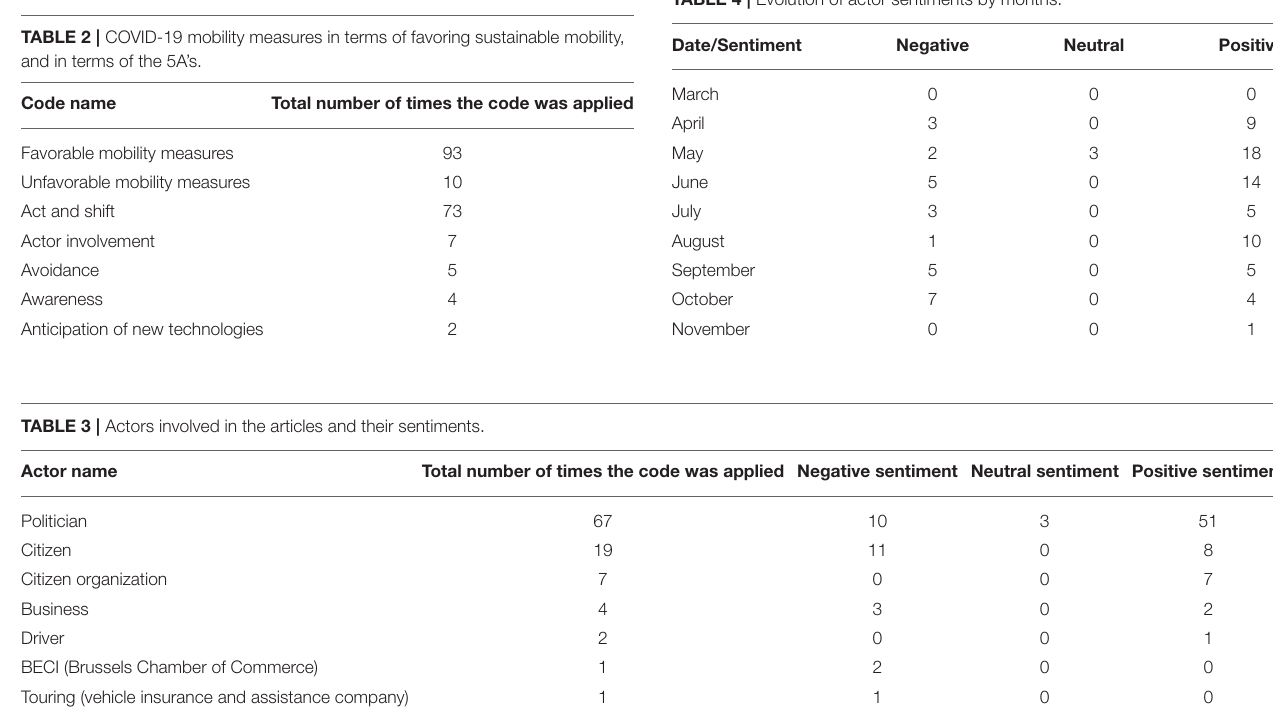
TABLE 4 | Evolution of actor sentiments by months.